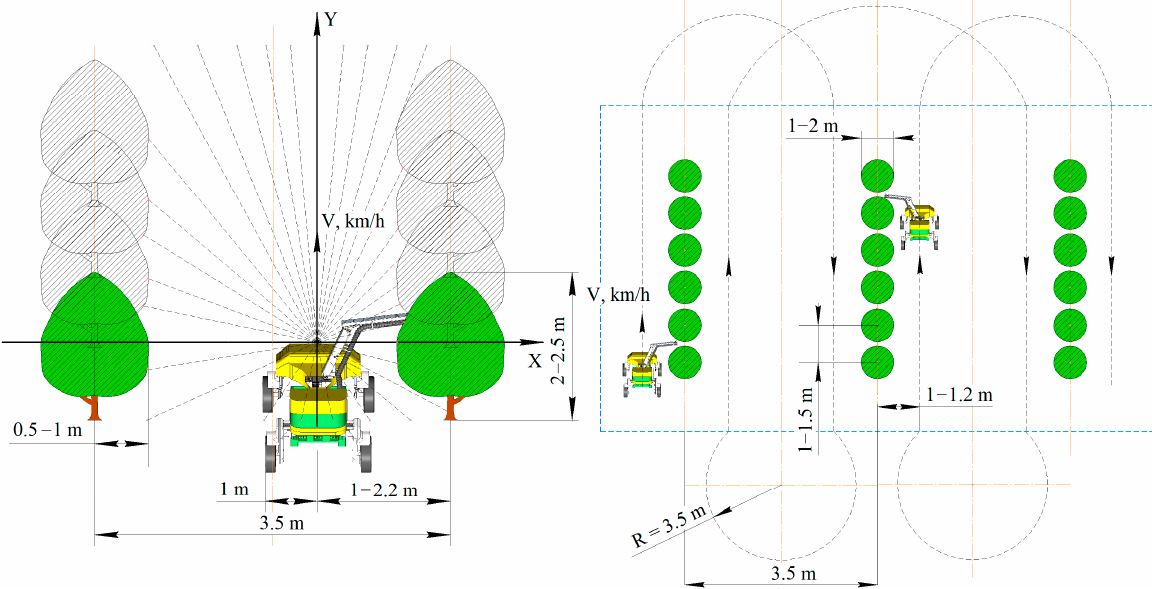
Figure 17. Garden parameters and the choice of the method of movement of the robotic platform. The chronology of the route “Apple fruit harvesting with shuttle mode of movement through a row, with a pear-shaped turn” is given in Table 1. Table 1. Chronology of the route “Apple fruit harvesting with shuttle mode of movement through a row, with a pear-shaped turn”.